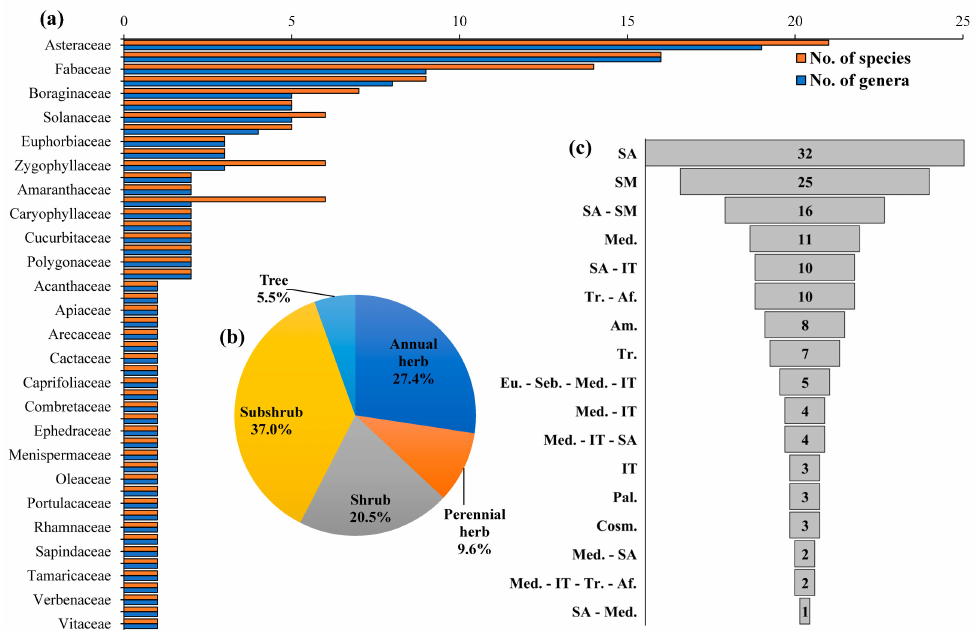
Figure 2. Floristic diversity in the 58 selected sampling stands in the western region of Saudi Arabia showed as the number of identified plant species and their families ( a ), the life forms of these species ( b ), and the chorotype spectrum in the study area ( c ). AF: African, Am.: American,